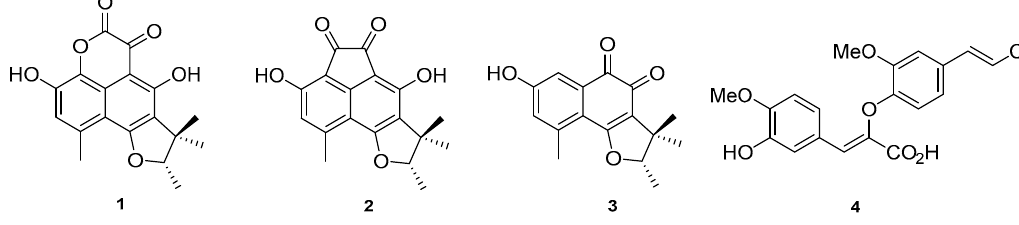
Figure 1. Secondary metabolites isolated from Pseudolophiostoma clematidis : scleroderolide ( 1 ) sclerodione ( 2 ), trypethelone ( 3 ) and the phenylpropanoid 8-O-4 ′ -diferulic acid ( 4 )